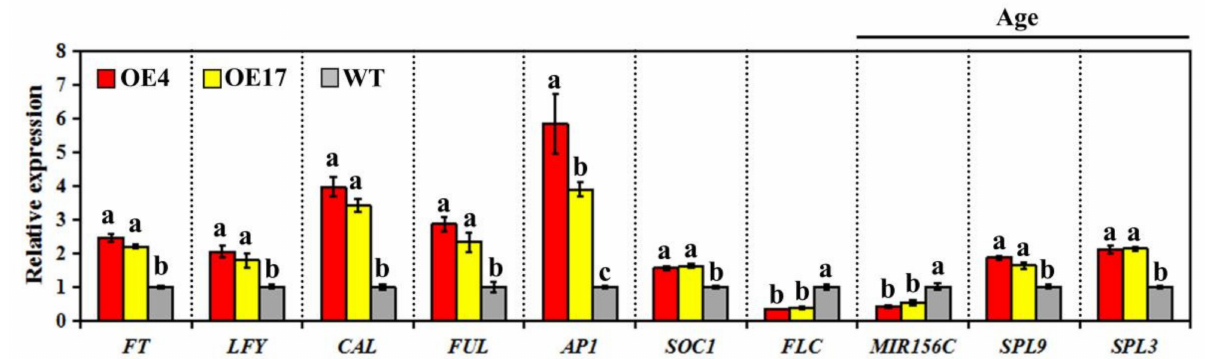
Figure 5. Transcript levels of flowering-related genes in CpWRKY75 transgenic plants and WT plants. Fifteen-old-day plants were used for qRT-PCR analysis. Data represent means ± SD of three biological replicates. Lowercase letters shown above the columns indicate significant differences (one-way ANOVA, Duncan’s multiple range test, p <